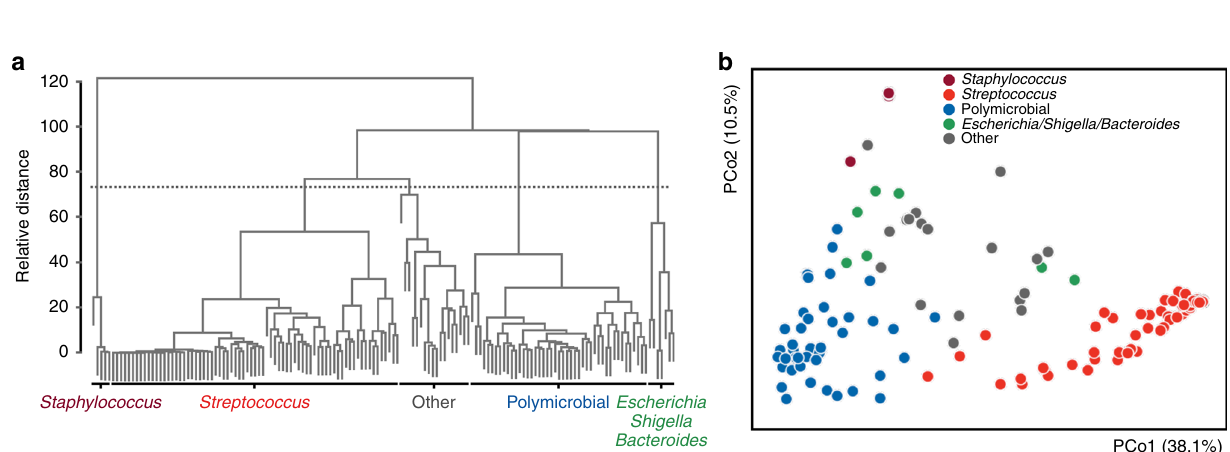
Fig. 2 NSTIs can be grouped into distinct infection types based on the associated pathobiome. a Patient classi fi cation ( n = 148) into different infection types based on their associated bacterial composition using hierarchical agglomerative clustering. Infection type de fi nitions are assigned based on the genus-level distribution of the associated bacterial composition. b Principal Coordinate Analysis (PCoA) of Bray – Curtis dissimilarities between the bacterial composition identi fi ed in all tissue biopsies ( n = 148), colored by infection type. Source data are provided in Supplementary Data 2 and